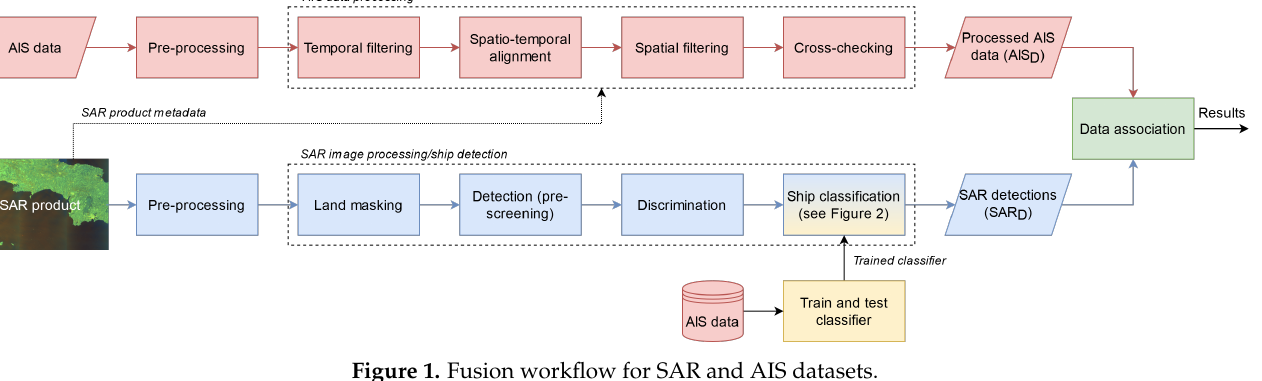
Figure 1. Fusion workflow for SAR and AIS